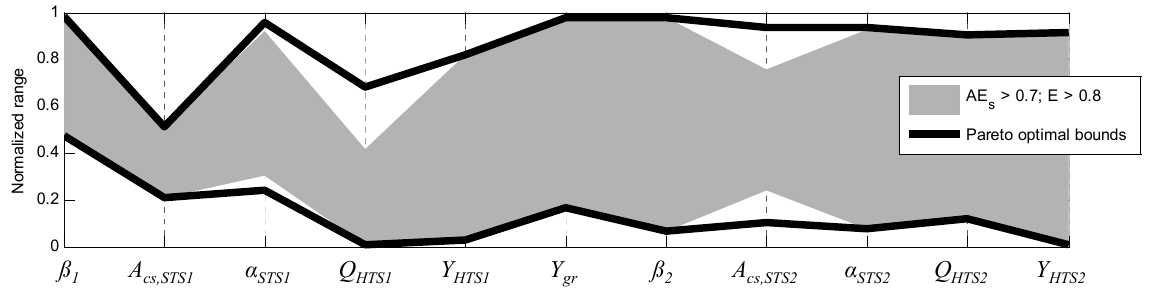
Fig. 7. The parameter bounds for 11 calibrated parameters within the normalized a priori seach space [0, 1]. The parameter sets which met the global and local performance criteria for single objective and two-objective tests, Levels 1 and 2, are used to define a narrowed search space (the grey shaded area) for the Level 3 and 4 calibrations. The black lines represent the bounds of the Pareto optimal parameter sets from Level 1 and 2